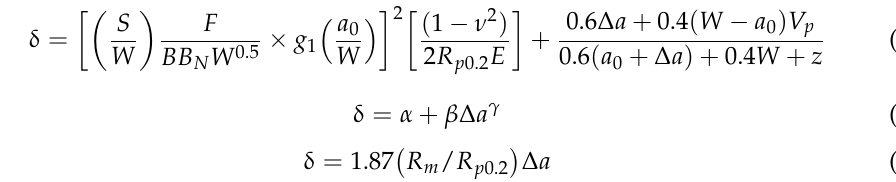
Table 4. δ 0.2BL values in different regions of the DMWJ.